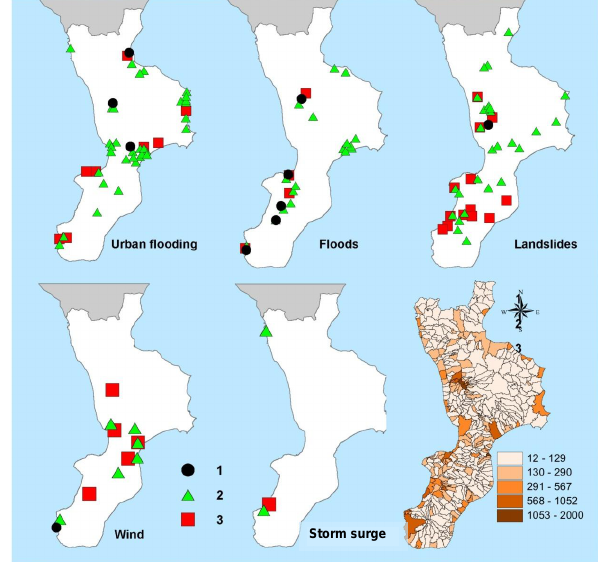
Fig. 2. Localisation of damage to people sorted according to the type of damaging agent. (1) Victims, (2) injured, and (3) involved people. The map on bottom-left represents the population density on a municipal scale (inhabitants per square